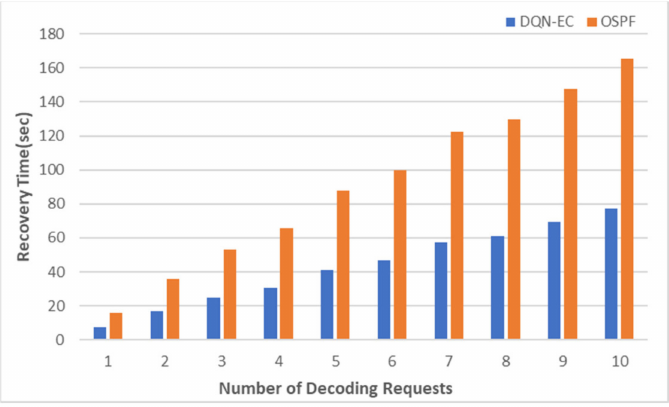
Figure 12. Recovery time based on number of decoding